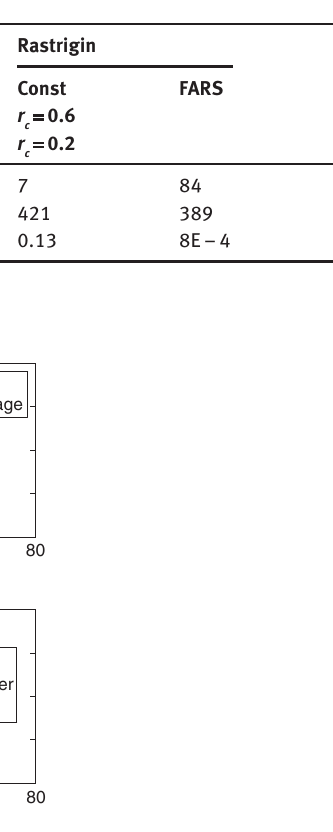
Figure 2: Sphere Function Minimization: Trend of GA Average Population and Best Individual Fitness (Upper Figure) and Recom- bination Rates (Lower